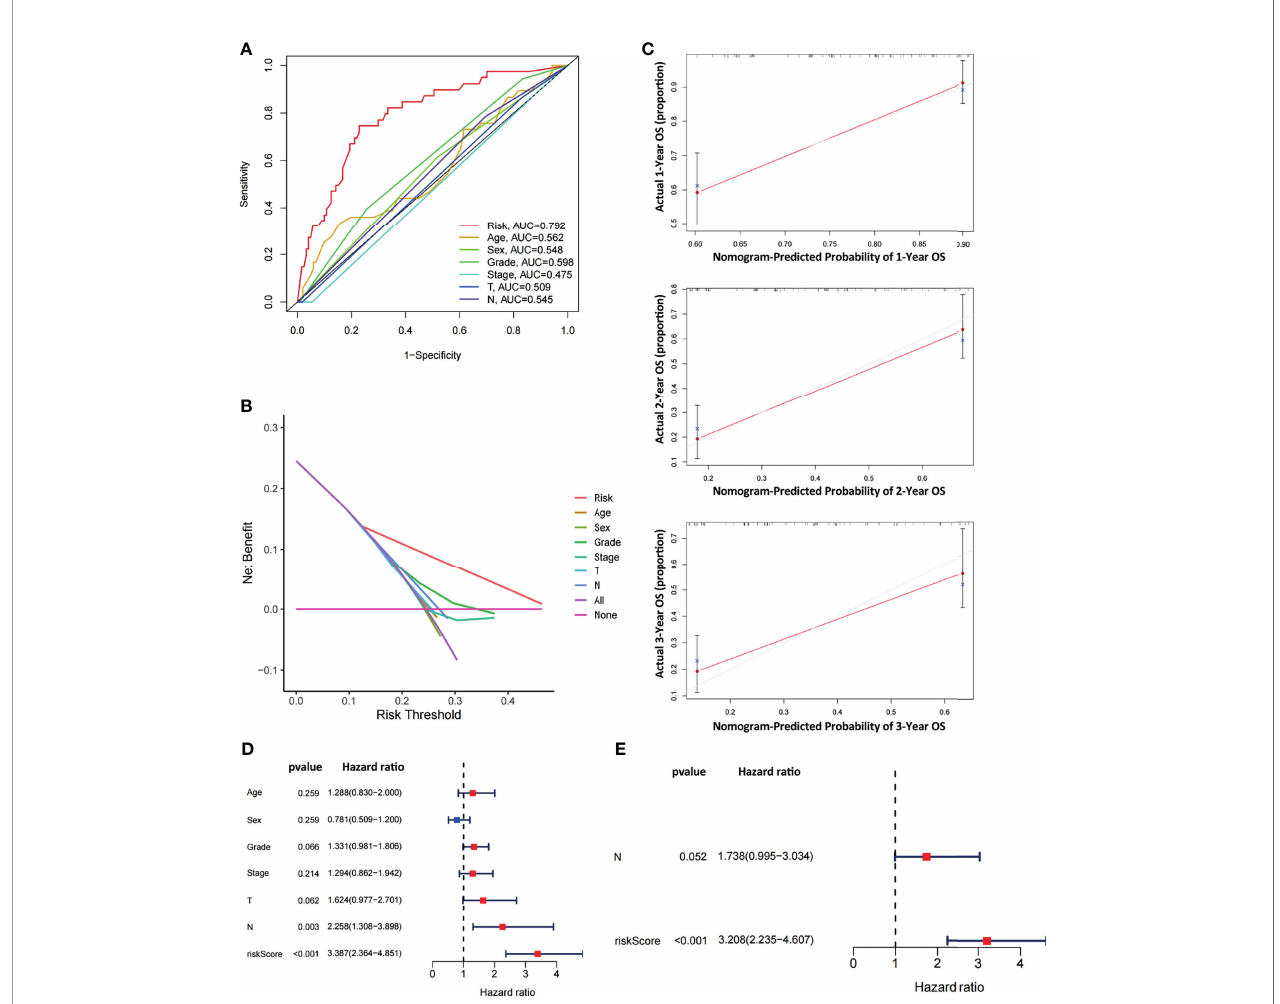
FIGURE 5 | Comparative analysis of diagnostic ef fi ciency between the risk score and clinicopathological characteristics. (A) AUC values of the risk score and clinicopathological characteristics. (B) DCA of the risk score and clinicopathological characteristics. (C) Calibration curves of the ARGP-based risk score in predicting the OS probability at 1/3/5 years in the TCGA dataset. (D, E) Univariate and multivariate analyses of prognostic factors in the TCGA cohort. T, N indicate T staging and N staging. The calculation of M staging is ignored due to too little